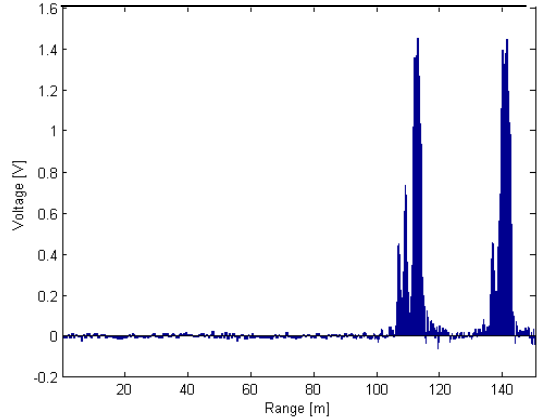
Figure 3. Multimodal waveform with clustered